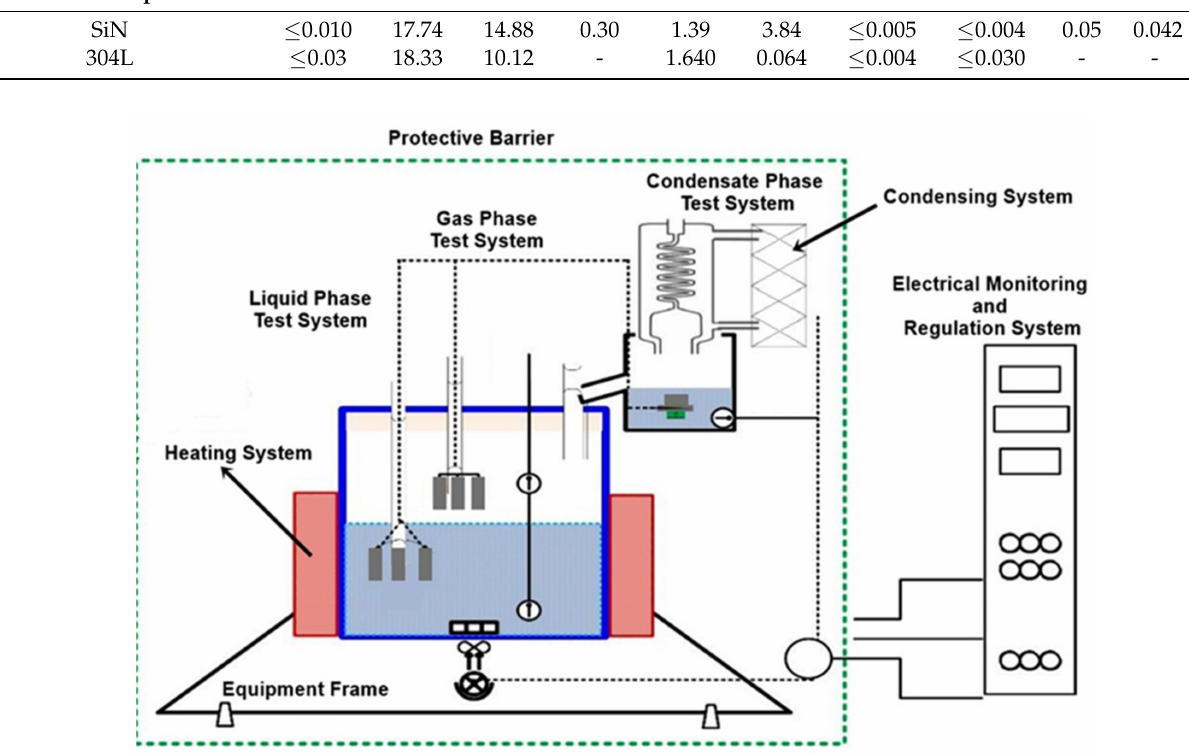
Figure 1. High-temperature nitric acid three-phase corrosion